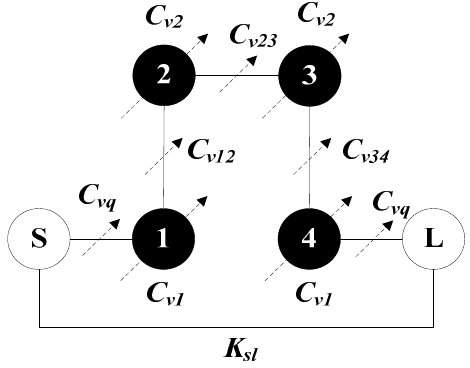
Figure 5. Coupling schematic for the proposed filter.